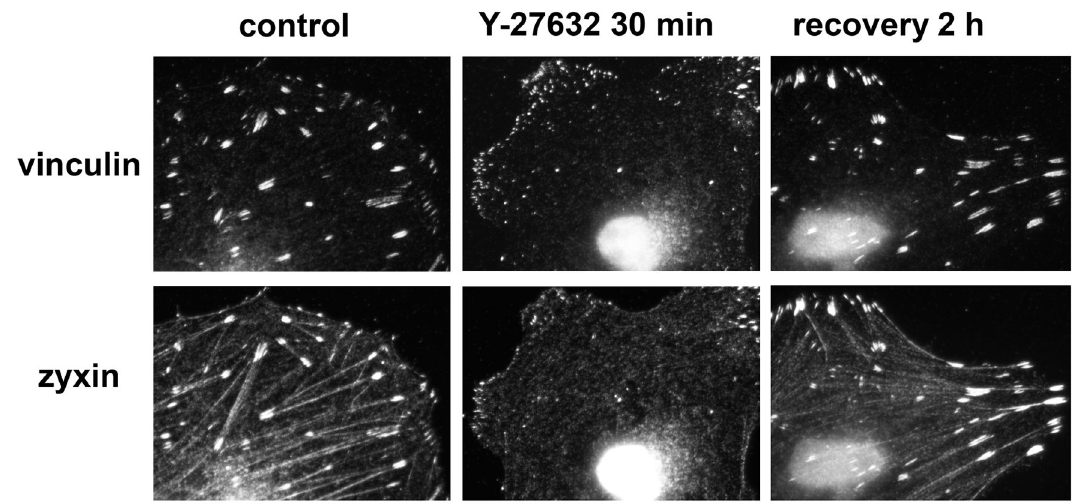
Figure 2. Reversibility of the effect of Y-27632 on cell morphology. Images of Y-27632-treated HeLa JW cells were taken prior to addition of the drug, after 30 min incubation with 10 µM Y-27632, and 2 h after the drug was washed off. The effect of Y-27632 on cell morphology was reversible, as cells regained normal morphology within 2 hours of reagent